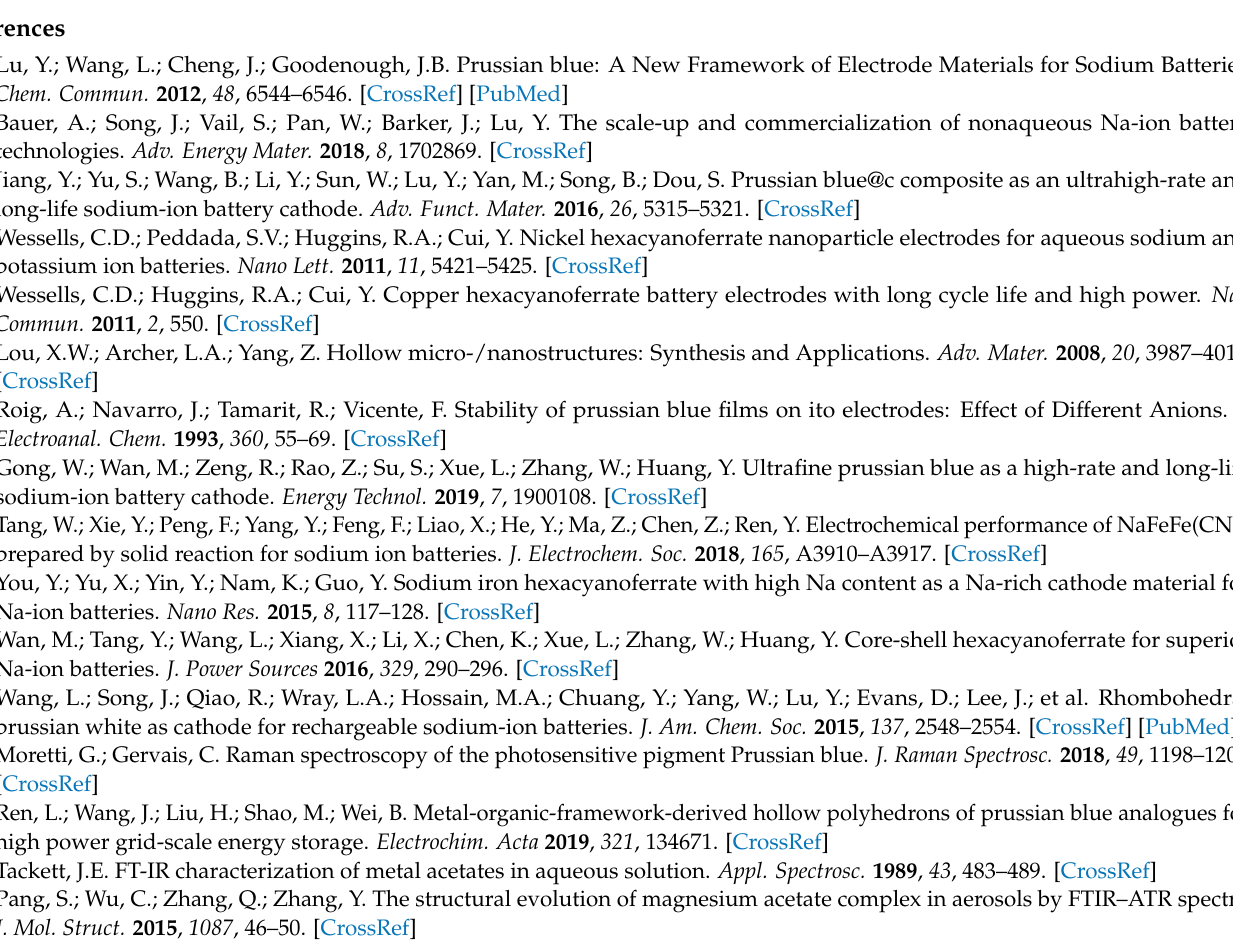
results of three samples; Figure S3: SEM images of three samples; Figure S4: TEM image of three samples; Figure S5: The adsorption/desorption nitrogen isotherms of three samples; Figure S6: BJH pore size distribution plots and TGA curves; Figure S7: Charge and discharge curve of the Sample-O and the Sample-S at various currents; Figure S8: CV curve of all the samples (range from 2.0 V to 4.0 V); Figure S9: Electrochemical impedance test result; Figure S10: